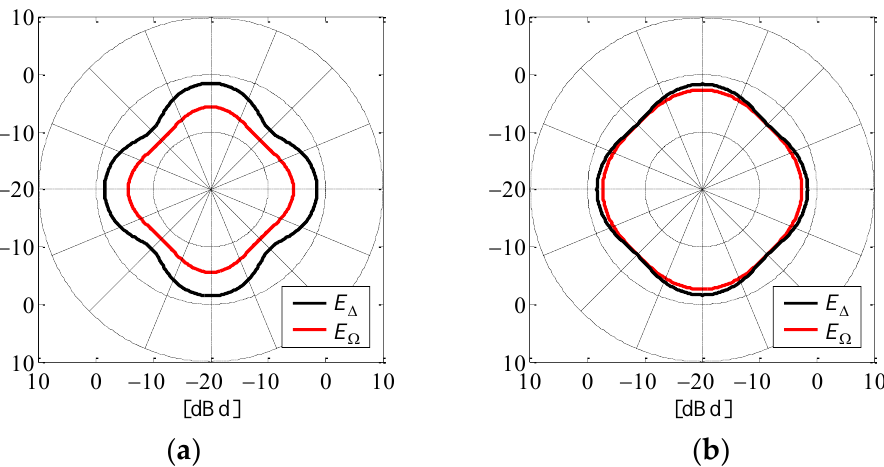
Figure 6. Amplitude radiation pattern of the AOA estimation function: ( a ) a = 4.9 cm and l = 7.5 cm; ( b ) a = 3.9 cm and l = 6.8 cm.